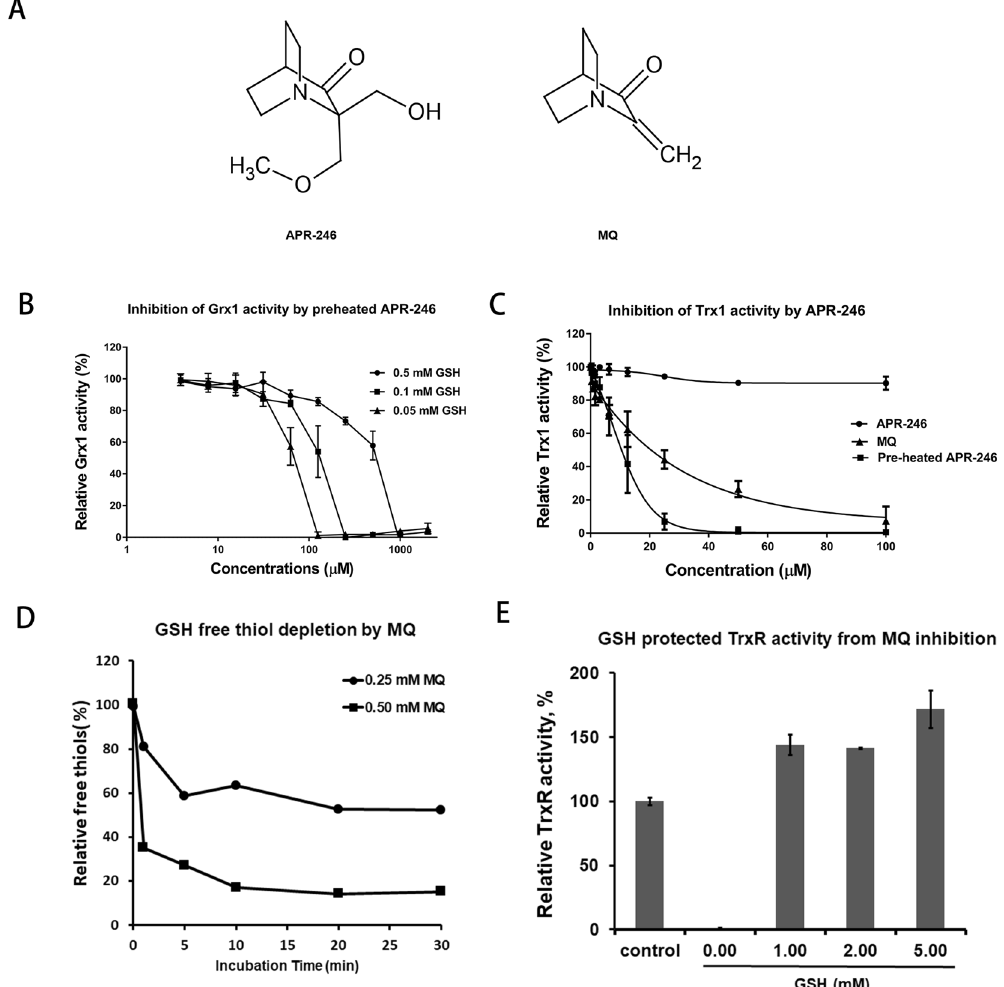
Figure 1. Inhibition of the GSH-Grx system and Trx system by APR-246. ( A ) The chemical structures of APR- 246 and MQ. ( B ) The GSH-Grx system (0.25 mM NADPH, 50 nM yeast GR, 50–500 µ M GSH, 0.1 µ M Grx1) was incubated with pre-heated APR-246 in a 96-well microtiter plate for 60 min. Grx1 activity was assayed by addition of 20 µ M E-GS-BSA. Data are shown as mean ± SD (n = 3). ( C ) Inhibition of Trx system by APR- 246, preheated APR-246 and MQ. After incubation of the Trx system (0.1 µ M Trx1, 50 nM TrxR, and 0.25 mM NADPH) with APR246, preheated APR-246, and MQ for 60 min, 6 µ M FITC-insulin was added to measure Trx activity. Results are shown as the means ± SEM of three experiments. ( D ) Time course of interaction of GSH with MQ. GSH (0.5 mM) was incubated with 0.25 and 0.5 mM MQ with various time points and unreacted free thiols in GSH were determined by titration with 2 mM DTNB. The reaction was shown to be a second order with a rate constant (k 2 ) of 21.6 M − 1 s − 1 . ( E ) Recombinant rat TrxR (0.5 µ M) was reduced by 200 µ M NADPH for 5 min and then incubated with 200 µ M MQ in the absence or presence of GSH at room temperature overnight. The GSH was then removed by Microspin TM G-25 columns and TrxR activity was measured by a DTNB reduction assay. TrxR without the treatment with MQ was used as control. Data are shown as mean ± SD (n =